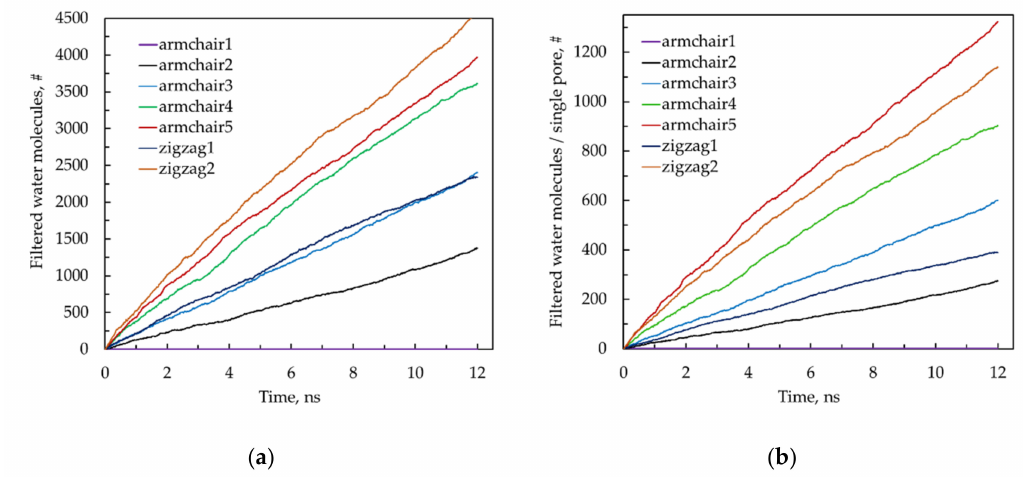
Figure 2. Number of filtered water molecules through the periodic fragment of the model membrane ( a ) and a single (individual) nanopore ( b ) as a function of time. See also Supplementary Materials Video S1 (MD simulation of water desalination with Armchair-3 model membrane at ∆ p = 50 MPa).